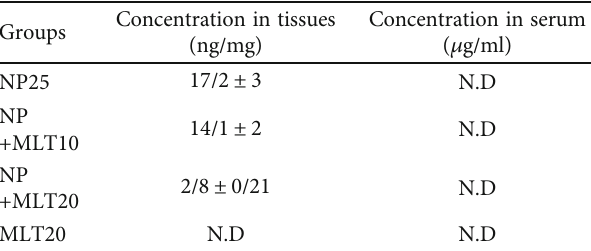
Table 1: Mean ( ± SD) of nonylphenol concentration in groups ( n = 4 ).